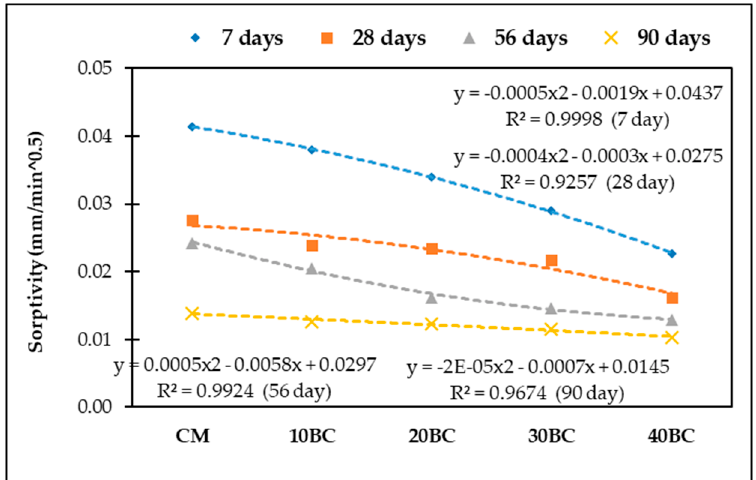
Figure 11. Regression equations for sorptivity.